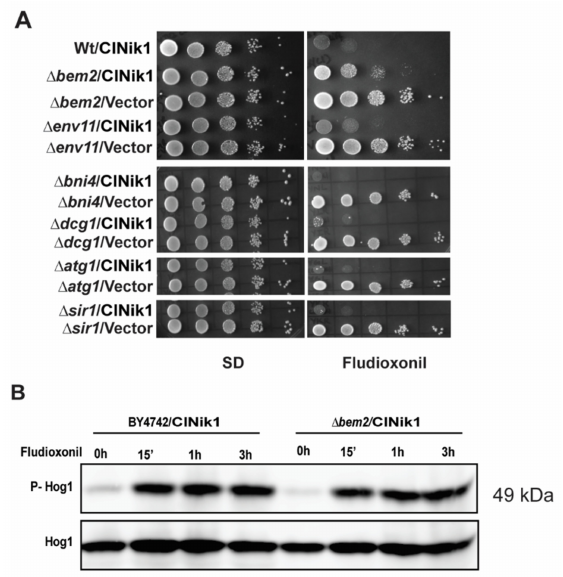
Figure 1. Identification of Bem2 as a downstream effector of fludioxonil toxicity. ( A ) Fludioxonil sensitivity of different S. cerevisiae strains identified by transposon mutagenesis by dilution spotting. Log phase cultures of different deletion mutants having pClNik1 were spotted on SD plate with or without 25 µ g/mL fludioxonil and incubated for two days at 28 ◦ C. ( B ) Western blots showing phosphorylation of Hog1 in wild type and ∆ bem2 strain carrying pClNik1 upon exposure to fludiox- onil. Cells were grown in SD media (-His) at 28 ◦ C till an OD 600 ~0.8 and treated with fludioxonil (25 µ g/mL) at different time intervals. Blots were analyzed using an anti-phospho-p38 antibody for phospho-Hog1 (P-Hog1) and anti-Hog1 antibody for total Hog1